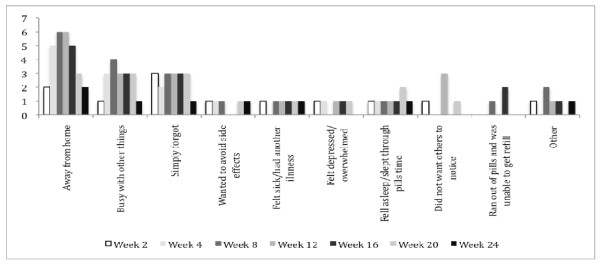
Percentage of the most frequent reasons for missing pills over weeks 2-24.